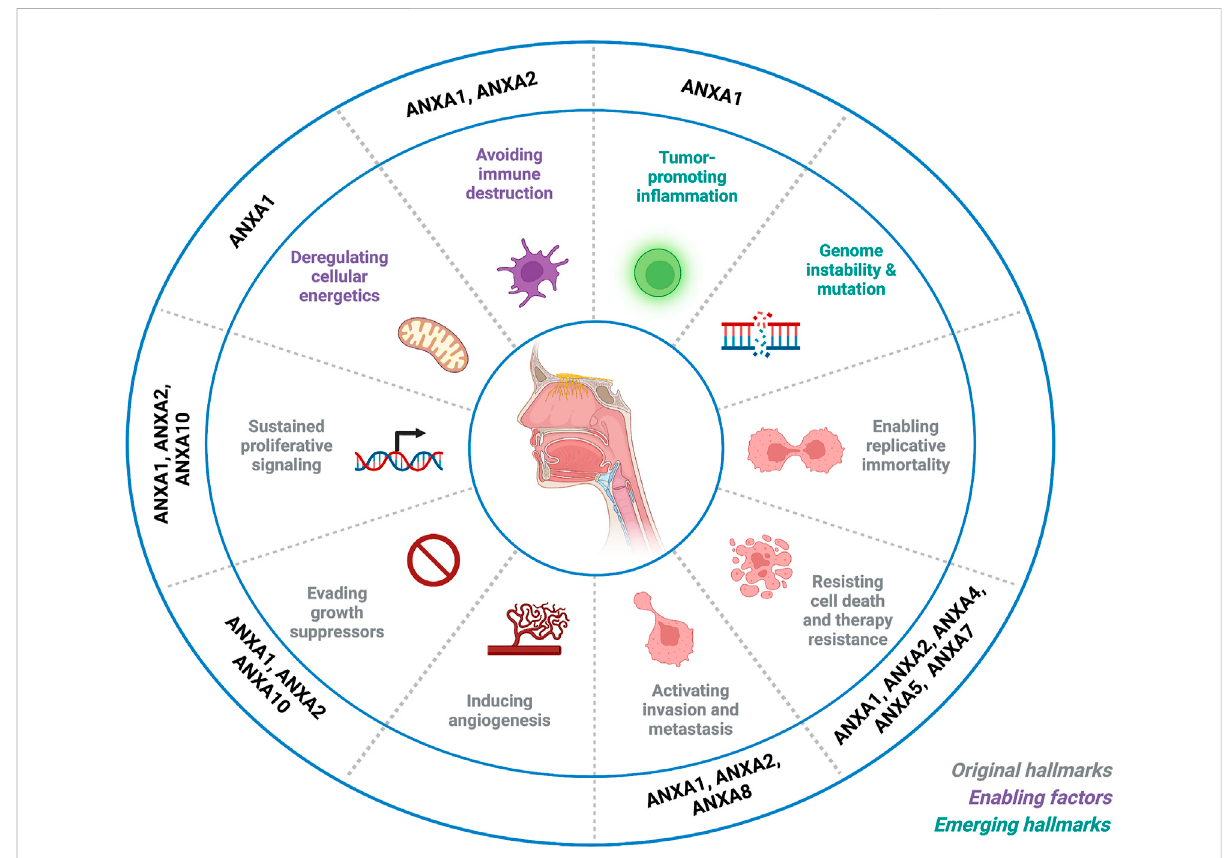
FIGURE 3 Impact of annexin dysregulation on the hallmarks of head and neck cancer. Schematic representation that summarizes current knowledge on annexin dysregulation in relation to the hallmarks of cancer de fi ned by Hanahan and Weinberg. Image created with BioRender.com.